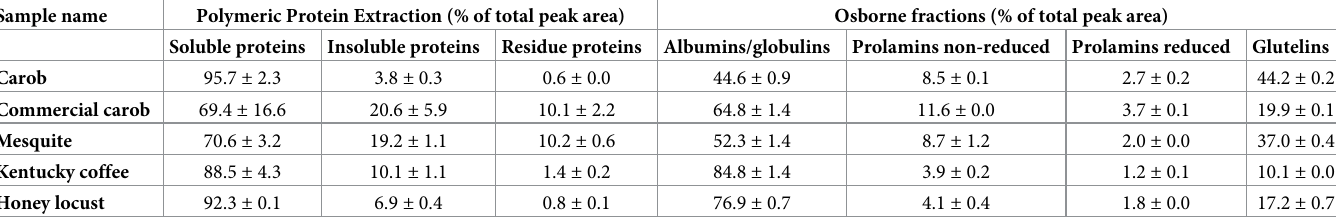
Table 1. The size exclusion chromatography of soluble, insoluble, and residue protein fractions from polymeric protein extraction procedure, and Osborne fractions. Sample